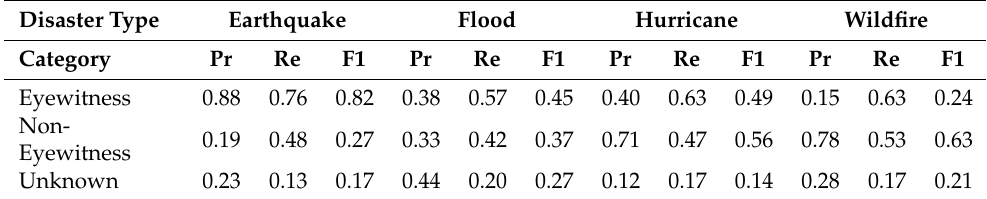
Table 9. Experiment-1: Manual Classification (F-Scores) 13-Features.